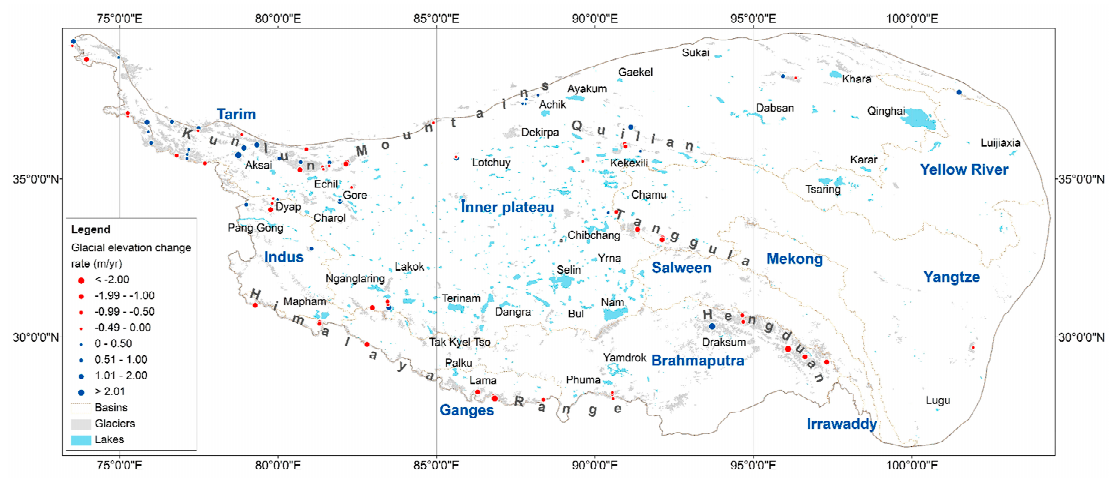
Figure 4. Glacial thickness change rates on the Tibetan Plateau between 2003 and 2009.